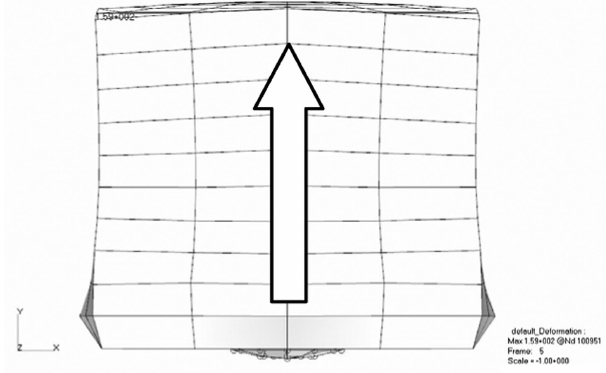
Fig. 9. TDA 6th mode: 1982 Hz – Y translation (axial).